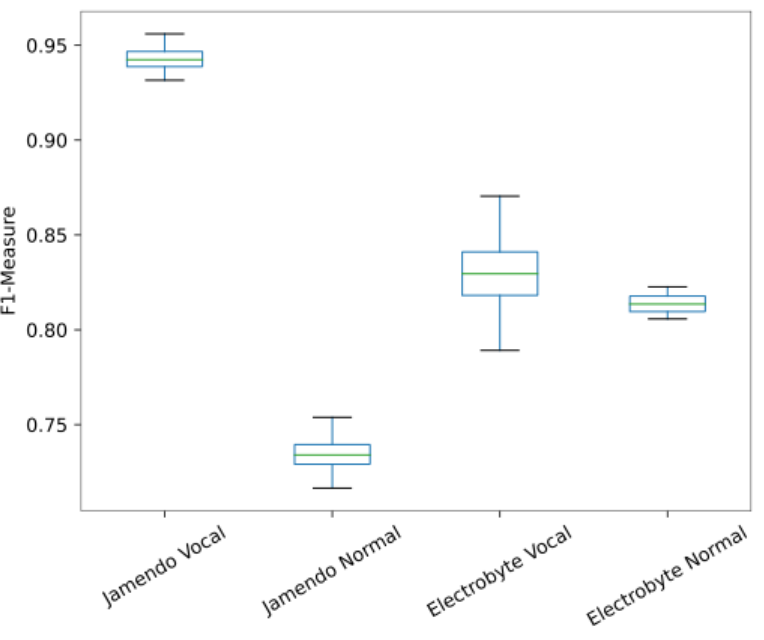
Figure 10. Performance of the LRCN when using and not using SVS as a preprocessing step.